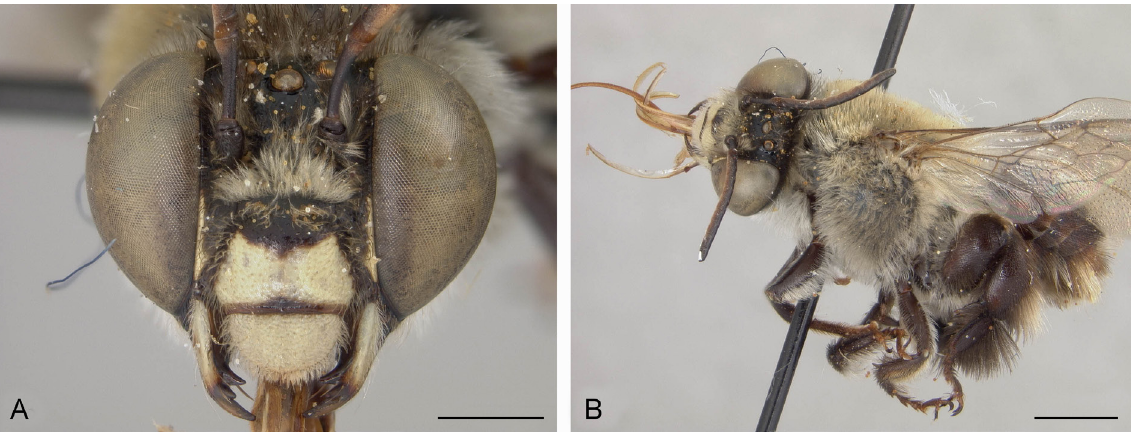
Fig. 12. Centris rhodadelpha Cockerell, 1939, holotype, ♂ (NMNH; USNM ENT 00534209). A . Frontal view. B . Habitus, lateral view. Scale bars: A = 1 mm; B = 2